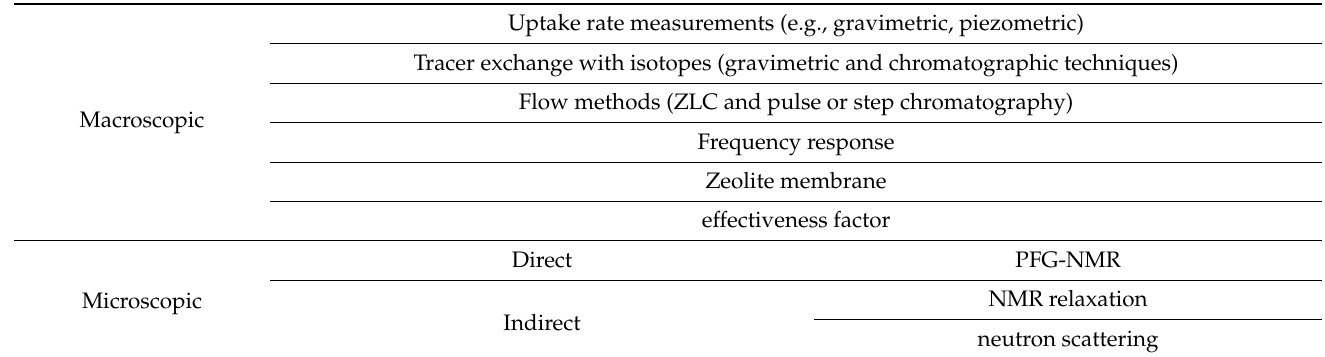
Table 2. Measurement techniques for intra-crystalline diffusion.